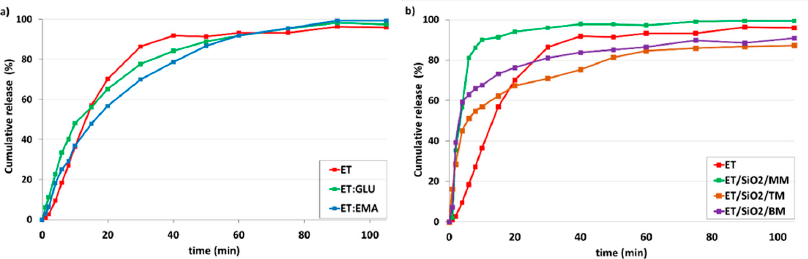
Figure 12. In vitro dissolution profiles of ( a ) ET and ET from ET:GLU, ET:EMA cocrystals, ( b ) ET and ET loaded in/on silica SiO 2 . Samples of ET in/on silica SiO 2 were prepared by three methods as described in legend. Simulated gastric fluid without pepsin (SGFsp, pH 1.2) was used as a dissolution medium. The estimated error in measurements was found to be +/ −